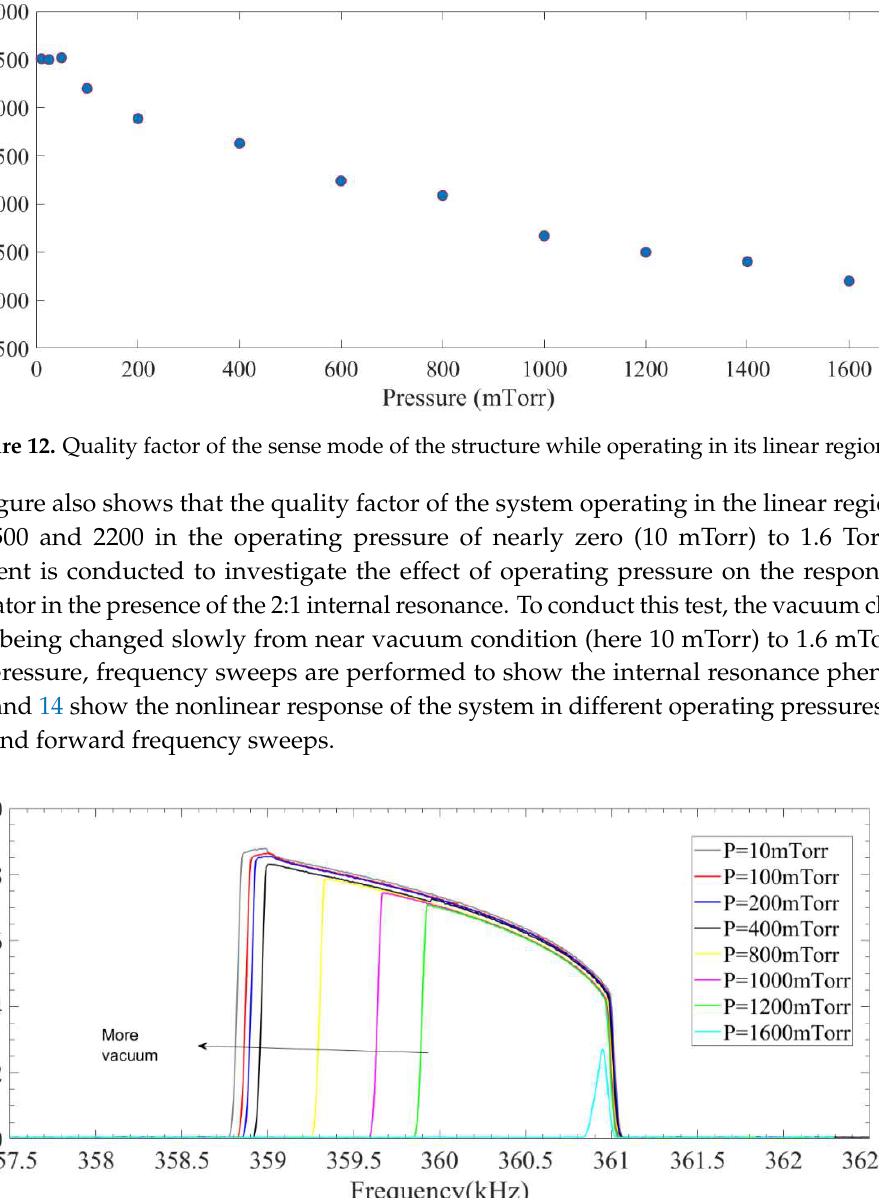
Figure 13. Effect of pressure on the performance of the system in the presence of internal resonance in a backward frequency sweep.